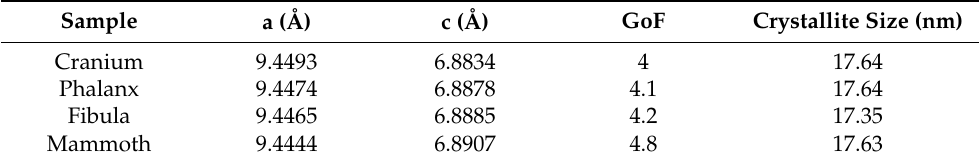
Table 1. Rietveld calculations of lattice parameters (i.e., a - and c -axes values, expressed in Angstrom— Å ) of hydroxyapatite crystals in bone mineral, the goodness of fitting (GoF) for these crystalline analyses, and the crystallite size ( D ) for all bone